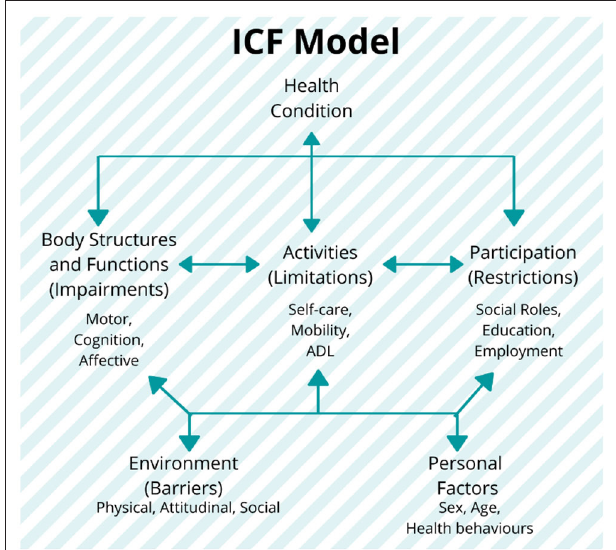
FIGURE 4 | The International Classification of Functioning, Disability, and Health (ICF) model and its components: the model establishes the three levels of human functioning: (1) at the level of body or body part (body structures and functions domain), (2) the whole person (activities domain), and (3) the whole person considered in a social context (participation domain). In this classification, disability implies a certain degree of dysfunction at one or more of these same levels: impairments, activity limitations, and participation restrictions, respectively. It also includes the additional information on the personal and environmental factors (World Health Organization, 2002). Figure is open access courtesy of the National Academies of Sciences (2021) (Trang et al.,